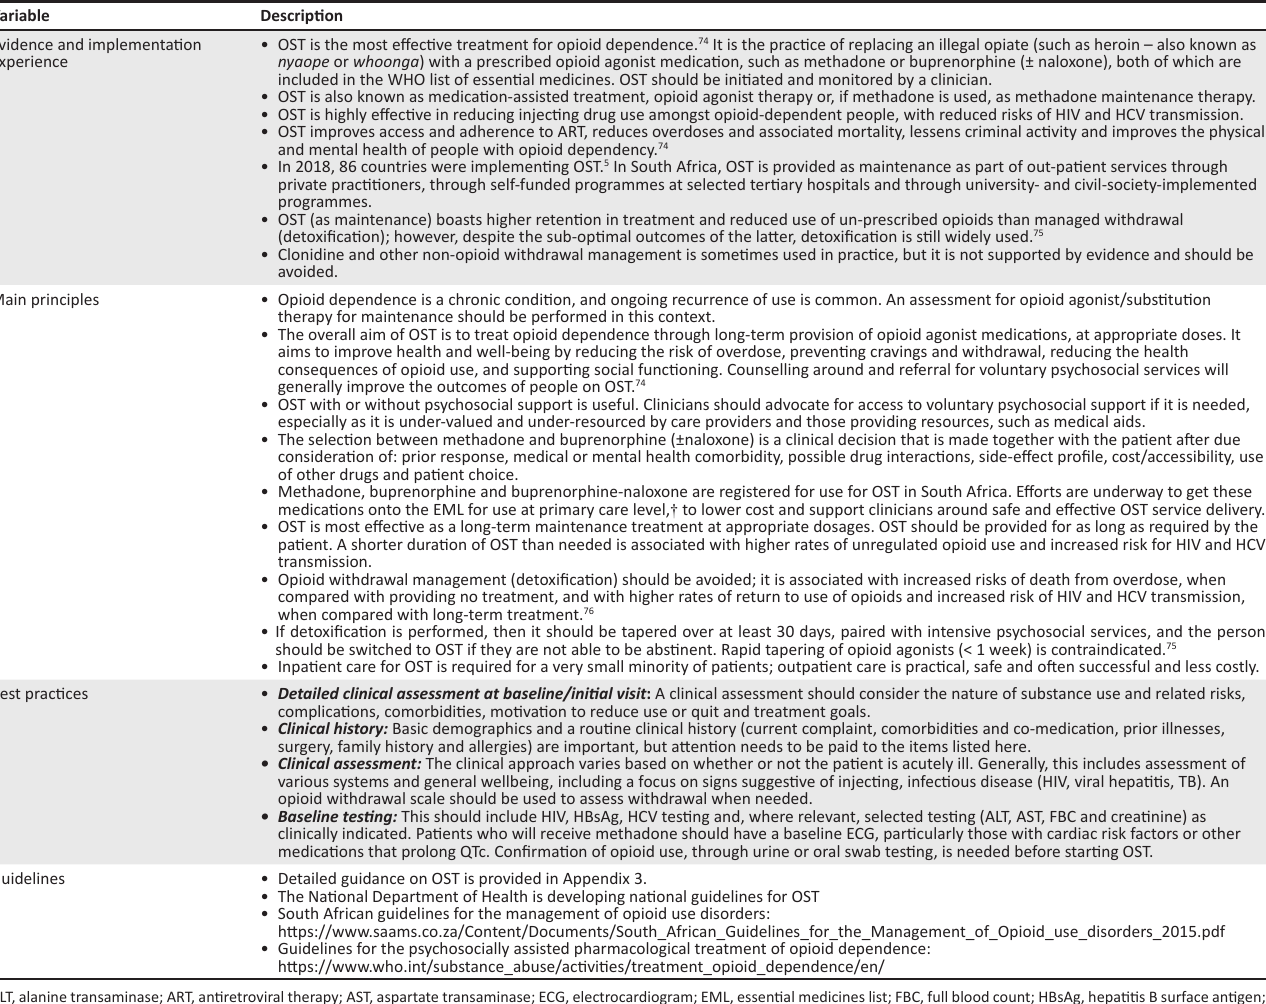
TABLE 16: Harm reduction interventions – Opioid substitution therapy. 74,81